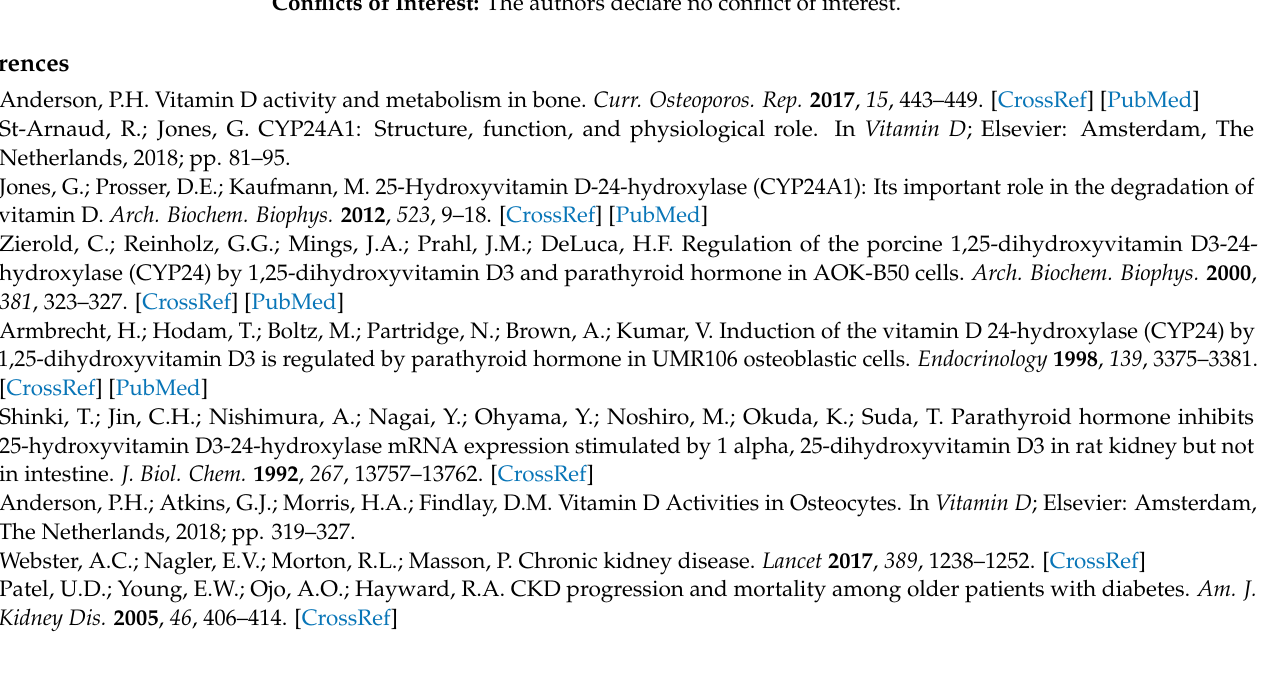
CDCl3; Figure S2: 13C NMR spectrum of VD1-2 in CDCl3; Figure S3: ESI MS spectrum of VD1-2 ; Figure S4: 1H NMR spectrum of VD1-3 in CDCl3; Figure S5: 13C NMR spectrum of VD1-3 in CDCl3; Figure S6: ESI MS spectrum of VD1-3 ; Figure S7: 1H NMR spectrum of VD1-4 in CDCl3; Figure S8: 13C NMR spectrum of VD1-4 in CDCl3; Figure S9: ESI MS spectrum of VD1-4 ; Figure S10: 1H NMR spectrum of VD1-6 in CDCl3; Figure S11: 13C NMR spectrum of VD1-6 in CDCl3; Figure S12: ESI MS spectrum of VD1-6 ; Figure S13: Chromatograms of 1,25(OH) 2 D 3 -DAPTAD samples; Table S1: Reproducibility of 1,25(OH) 2 D 3 LC-MS/MS analysis